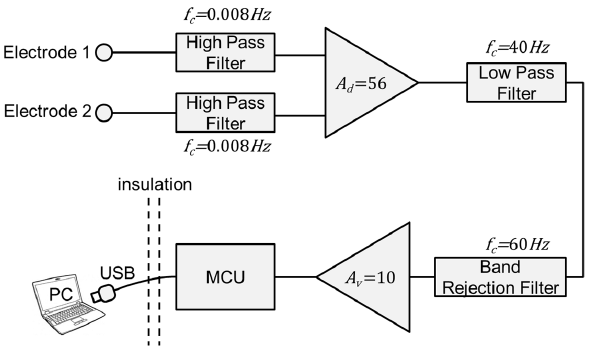
Figure 2. Structure diagram of hardware system for signal acquisition.